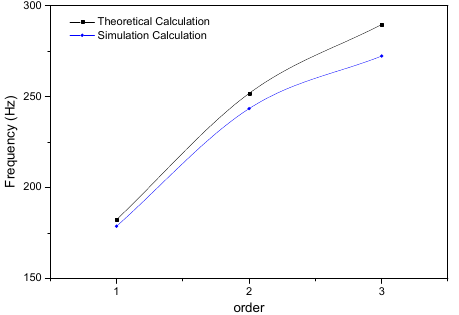
Figure 14. Comparison between theoretical and simulation calculation results.